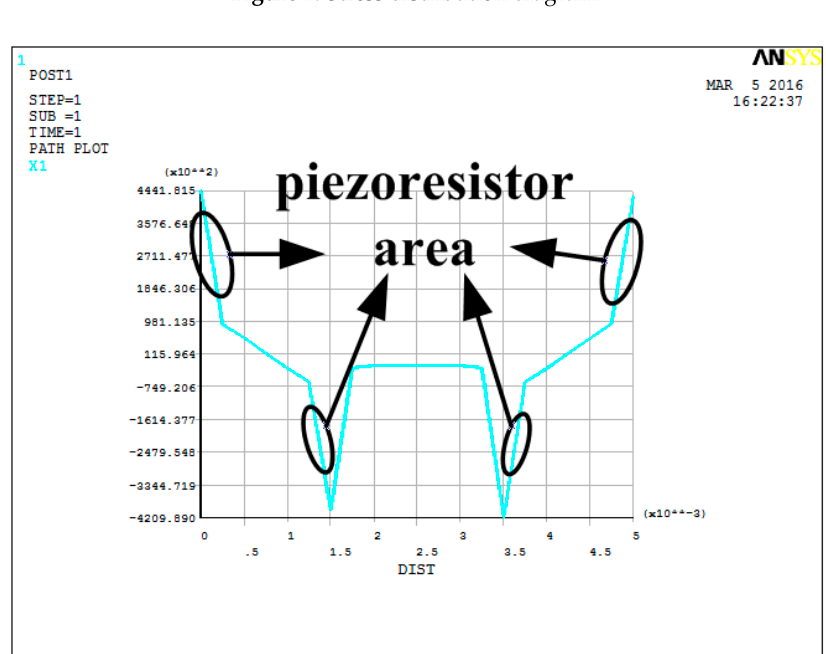
Sensors 2016 , 16 , 1728